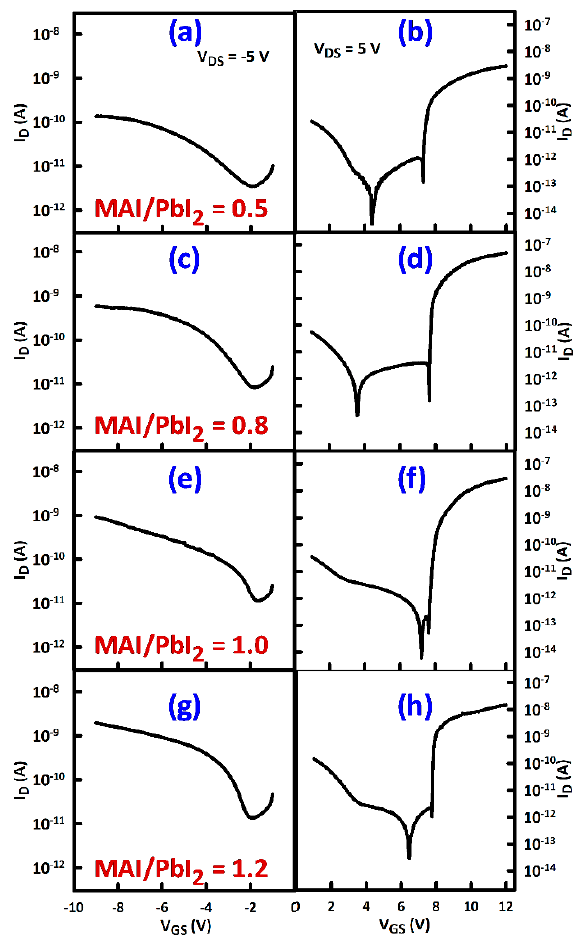
Figure 8. P-type and n-type transfer characteristics (log | I D | vs. V GS plots) of a MAPbI 3 TFTs with MAI/PbI 2 ratio of ( a, b ) 0.5, ( c, d ) 0.8, ( e, f ) 1.0, and ( g, h ) 1.2. W = 100 μ m and L = 50 μ m.